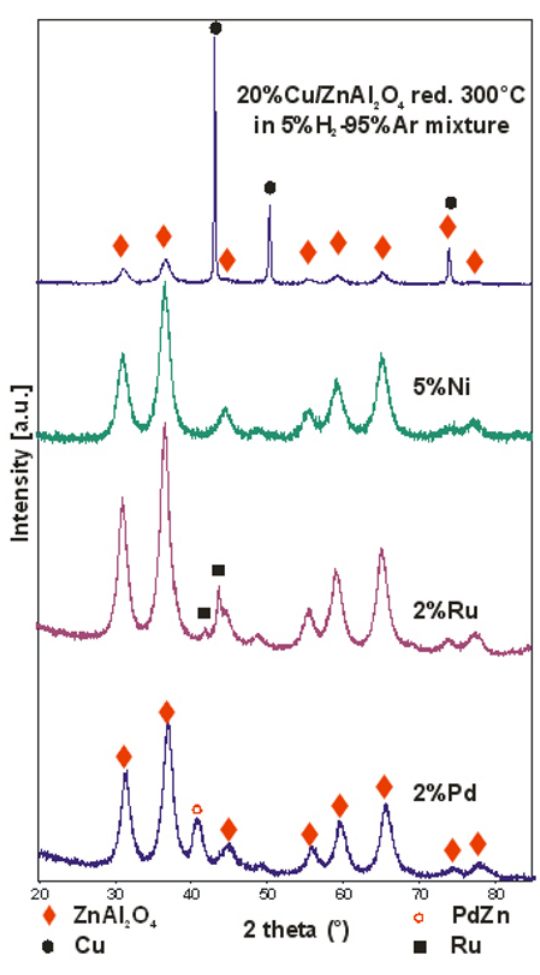
Figure 2. XRD patterns for Ni, Ru, Pd, catalysts after reduction at or at 300°C in 5%H -95%Ar mixture in 350°C in pure H 2 2 the case of copper